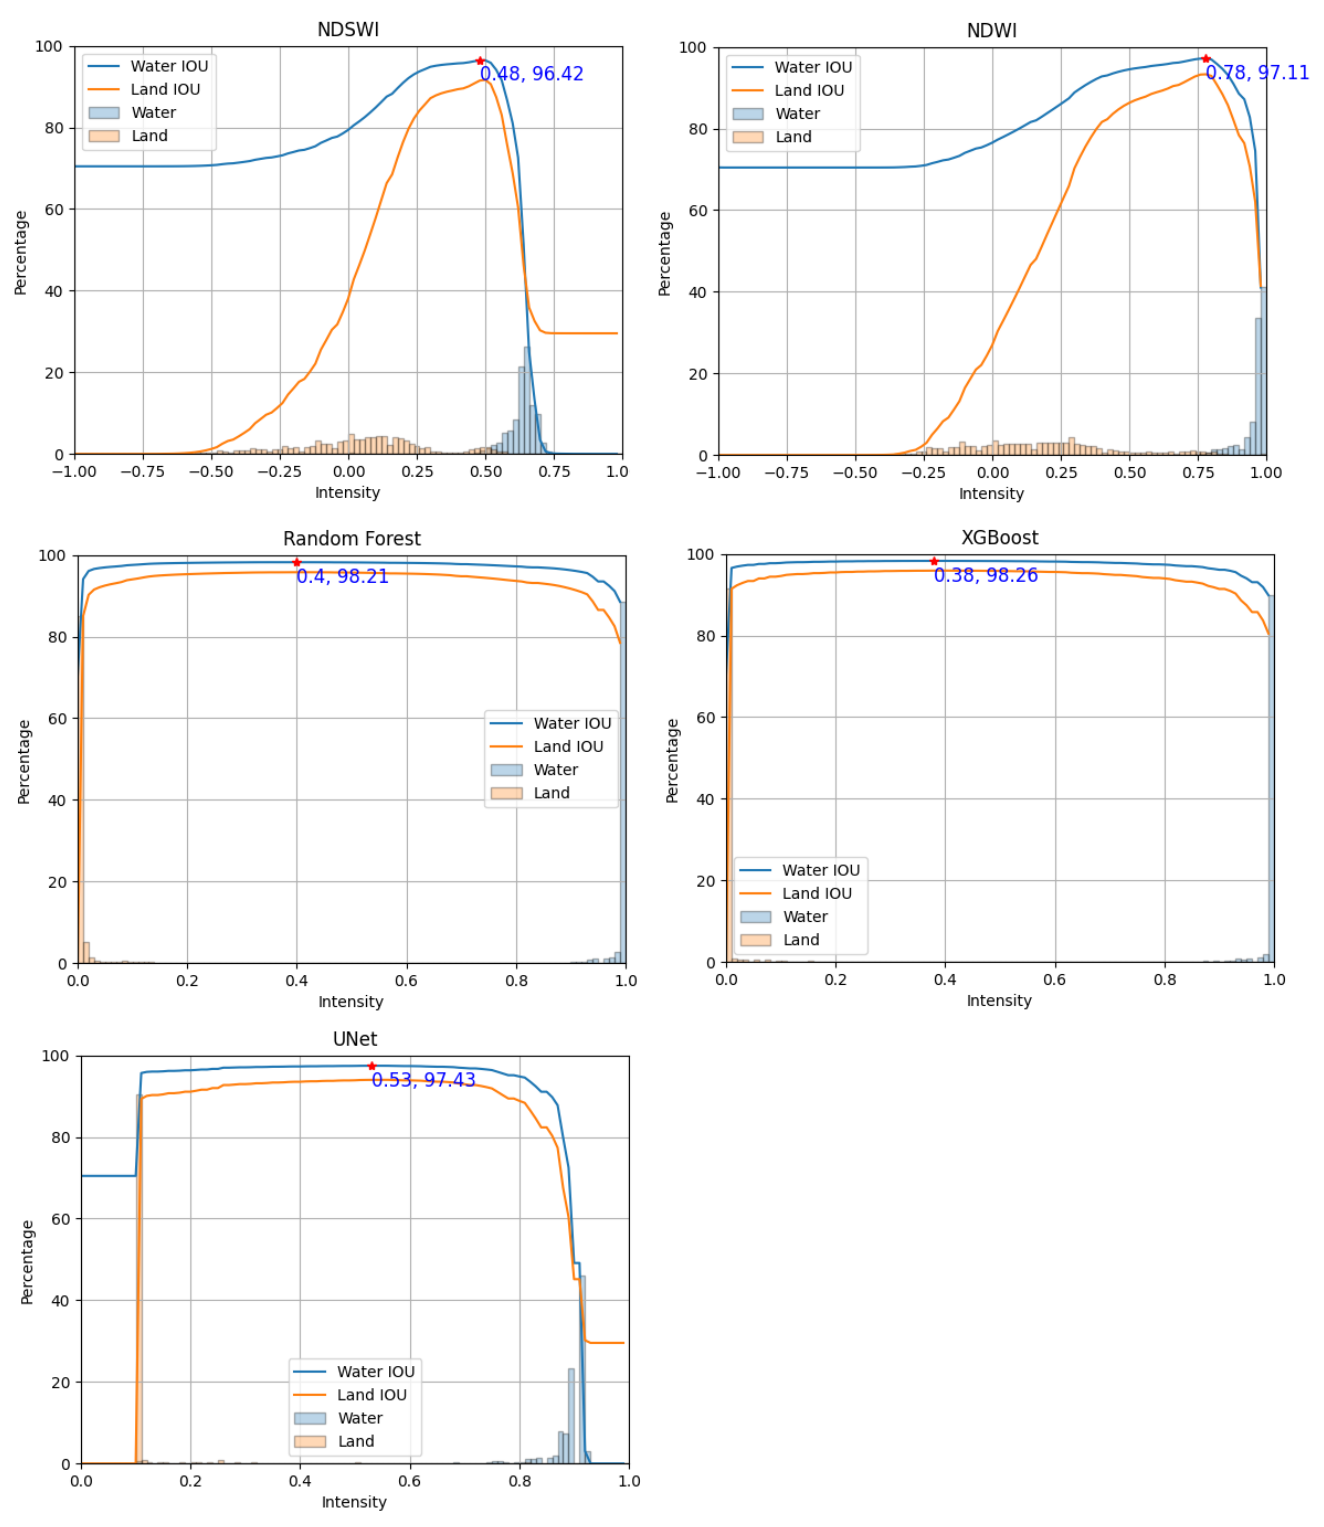
Figure 8. Binary mask generation by